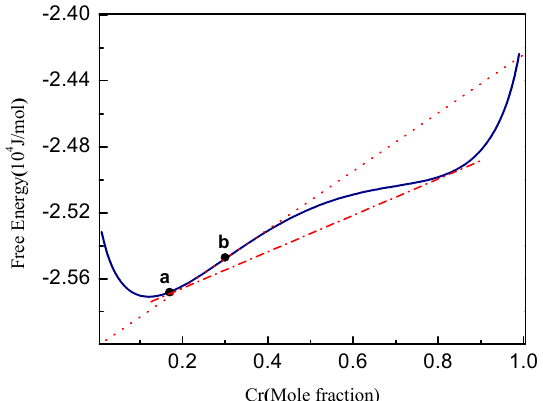
Figure 1. Free energy of the Fe-Cr alloy at 750 K, point a with Cr concentration c Cr = 0.17 delegates the boundary composition of phase separation, point b ( c Cr = 0.30) delegates the critical composition of spinodal decomposition. The dotted line is the tangent through the spinodal boundary and dash-dotted line is the tangent of equilibrium composition.